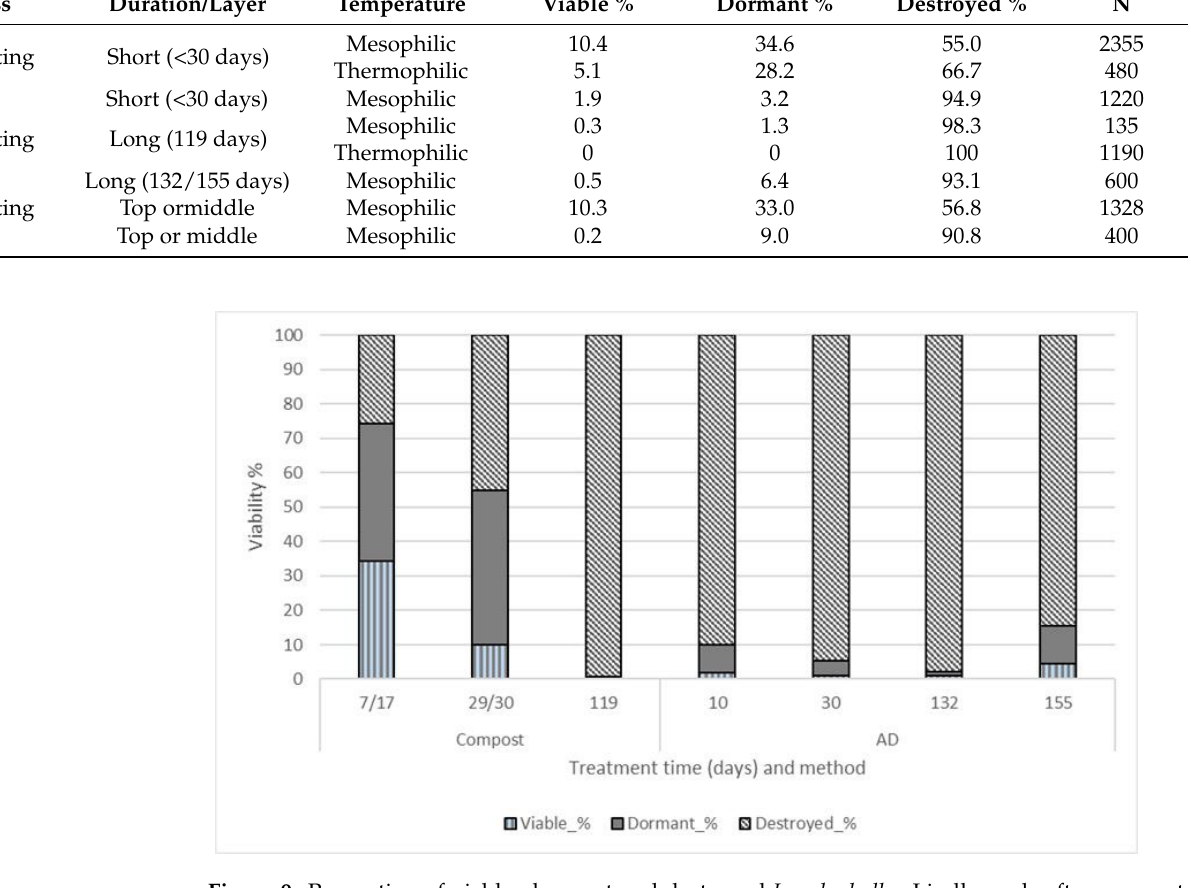
Figure 9. Proportion of viable, dormant and destroyed L. polyphyllus Lindl. seeds after composting and AD processes. Results from different experiments are combined based on the duration of treatment.